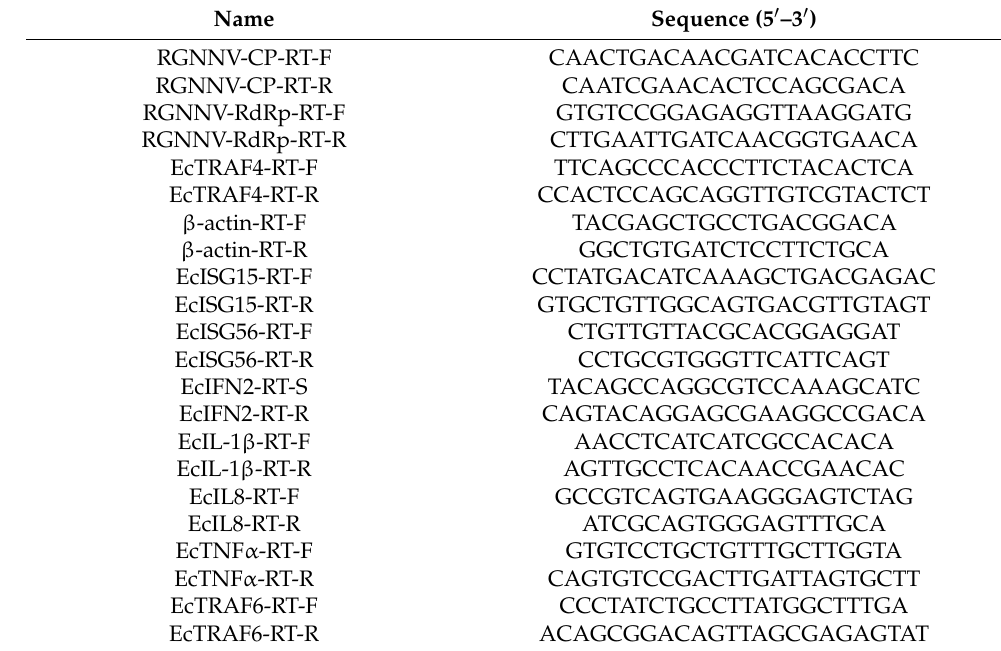
Table 1. Primers used for host and viral gene expression